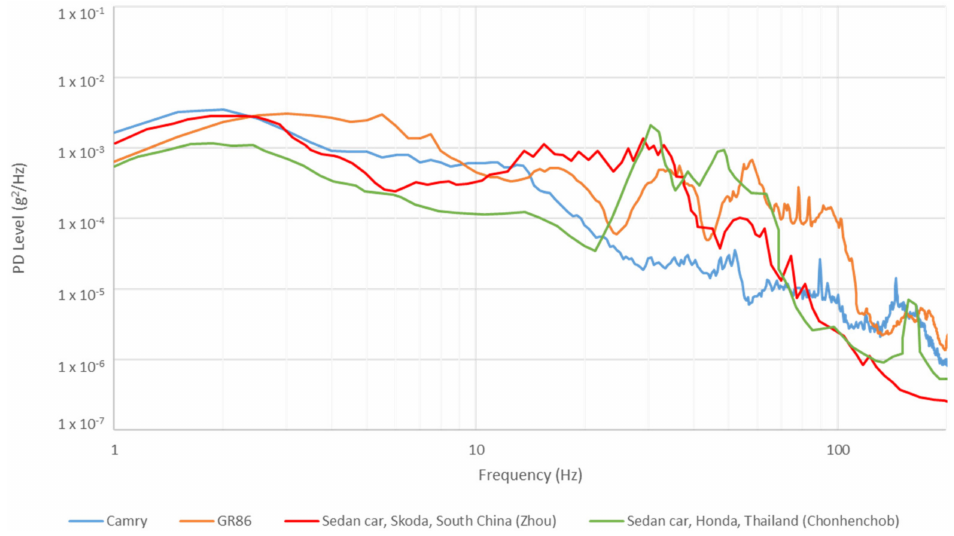
Figure 8. PSD plot comparison of sedan